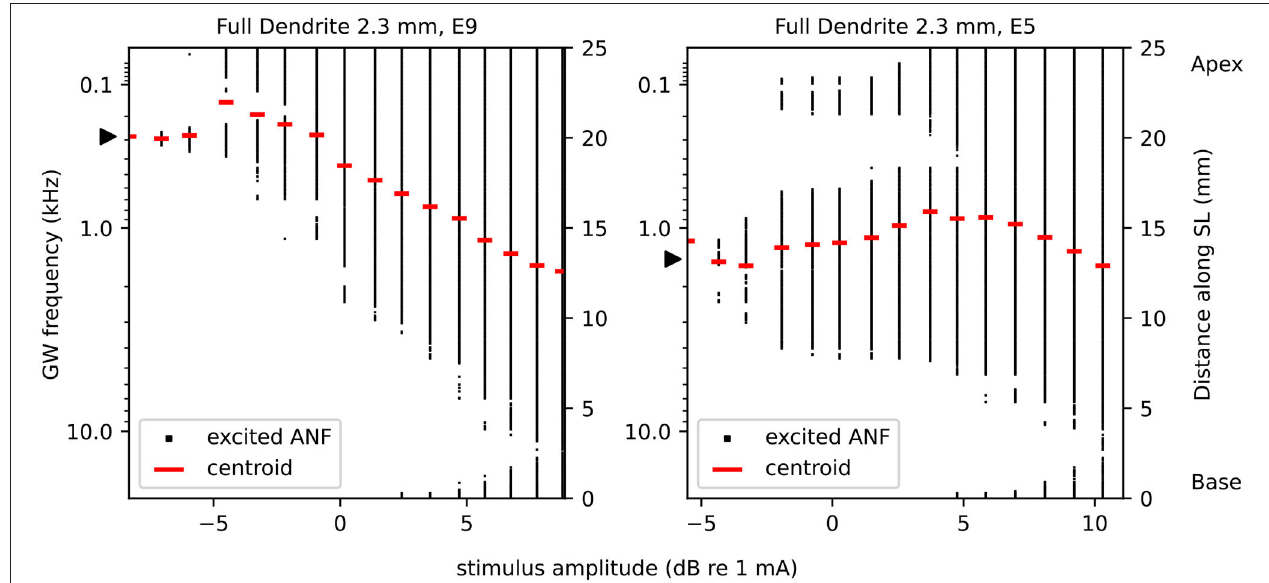
FIGURE 5 | Excited fibers and corresponding centroids, exemplary for FD 2.3 electrode 9 (left) and electrode 5 (right). Electrode 9 features a decrease and subsequent increase of pitch corresponding to the centroids with increasing stimulation amplitude. Electrode 5 features ectopic activation. For purpose of better visualization, we included here only a selective number of stimulation amplitudes. The electrode position is mapped to its nearest fiber, indicated by a black triangle. The left ordinate shows the frequency map, right ordinate the position of ANFs along the spiral lamina